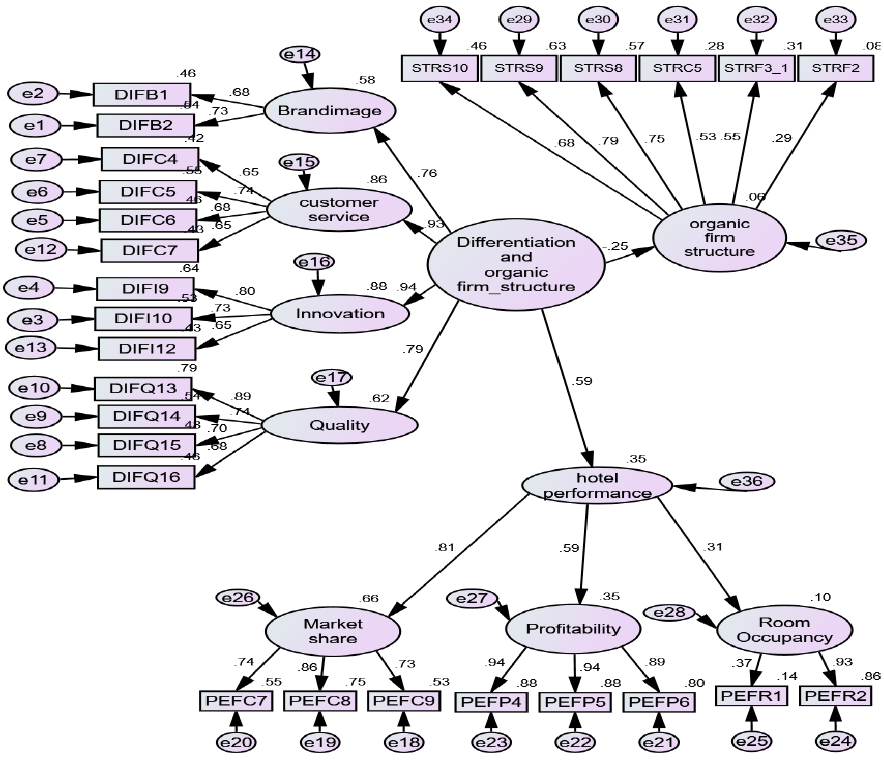
Figure 4: Structural equation model on joint influence of differentiation strategy and organic firm structure on organizational performance of star rated hotels in